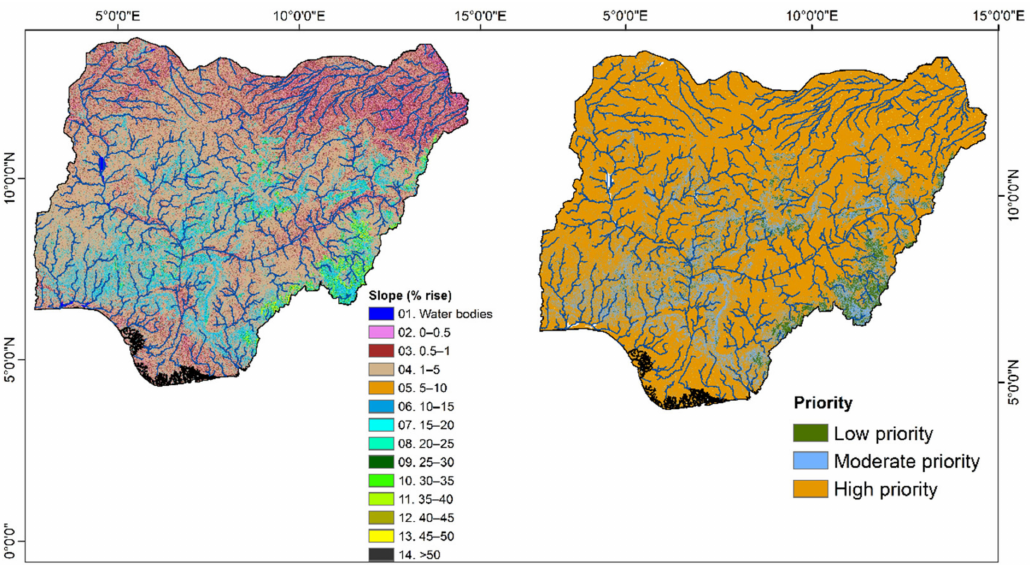
Figure 4. Slope map of Nigeria (SRTM DEM: http://srtm.sci.cgiar.org/) (accessed on 11 January